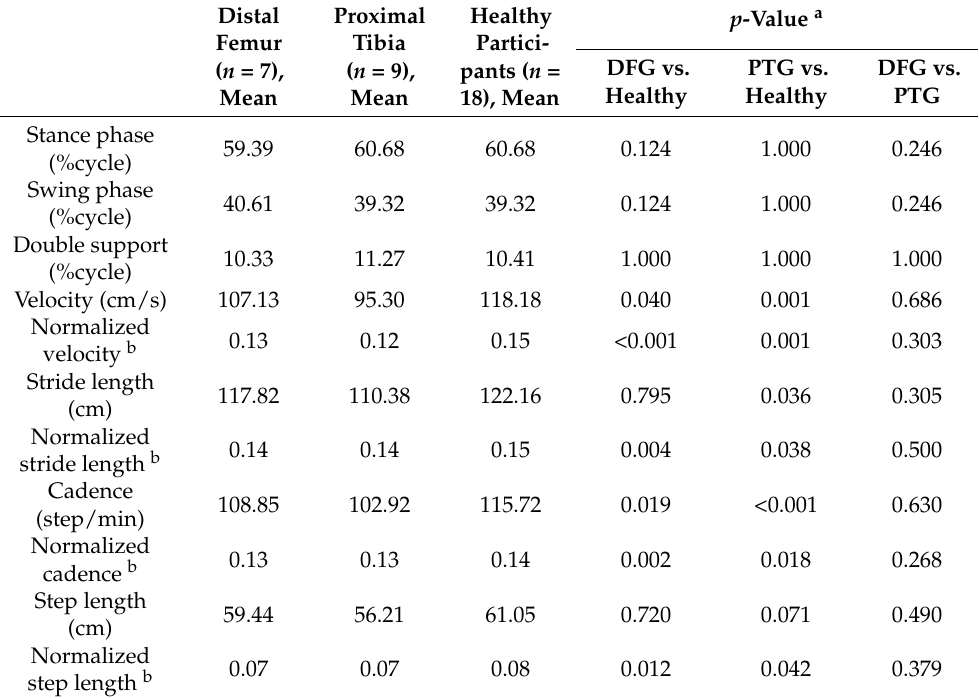
Table 4. Comparison of spatiotemporal gait parameters between patients and healthy